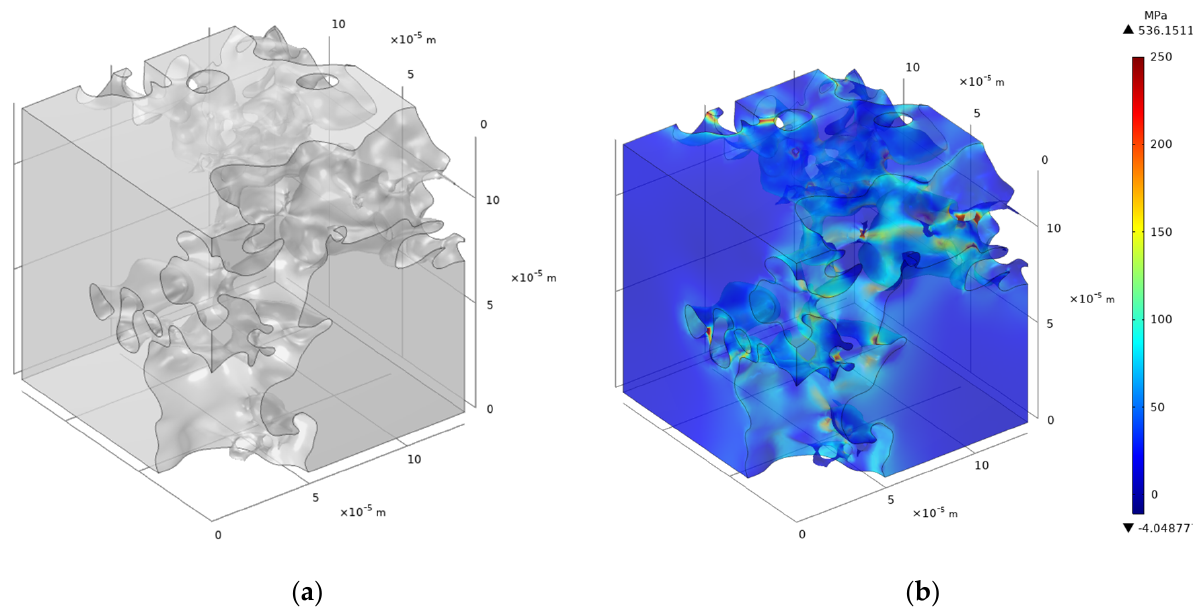
Figure 2. 3D volcanic model image used in this study. ( a ) Represents the digital rock; ( b ) represents the resulting simulated strain diagram.